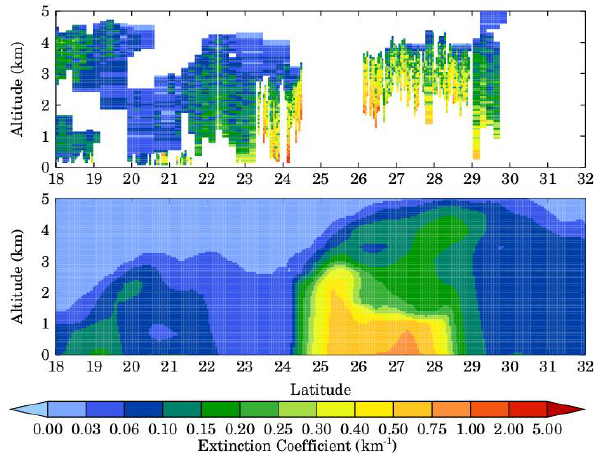
Fig. 7. Comparison of CALIPSO retrived extinction coefficient at 532nm (top panel) with WRF-Chem simulated extinction coeffi- cient at 550nm (lower panel) on 20 April 2010.